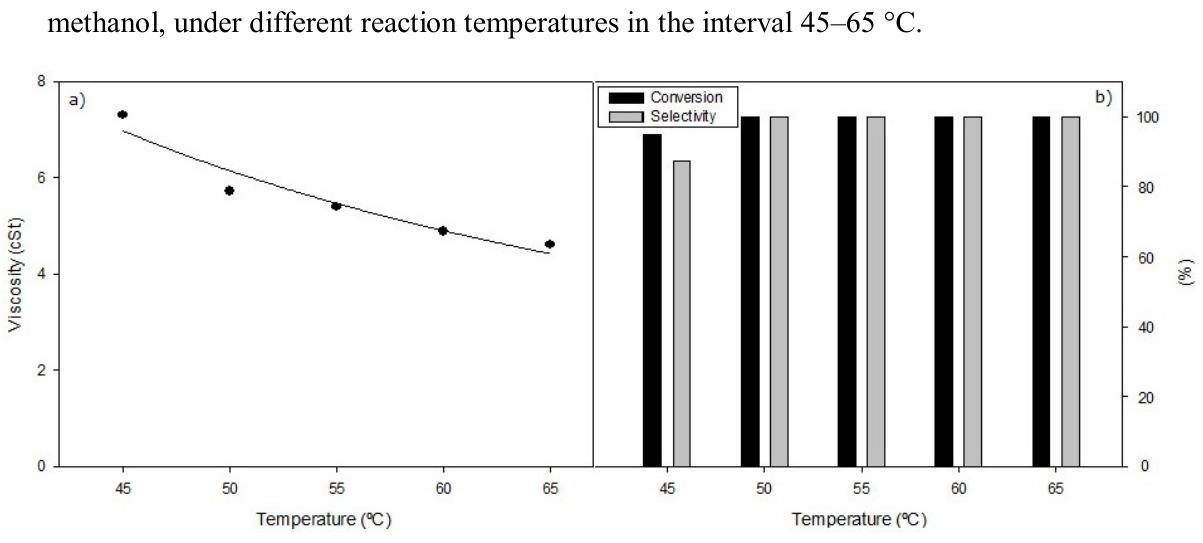
O catalyst, 12 mL of oil and 2.43 mL of 2 3